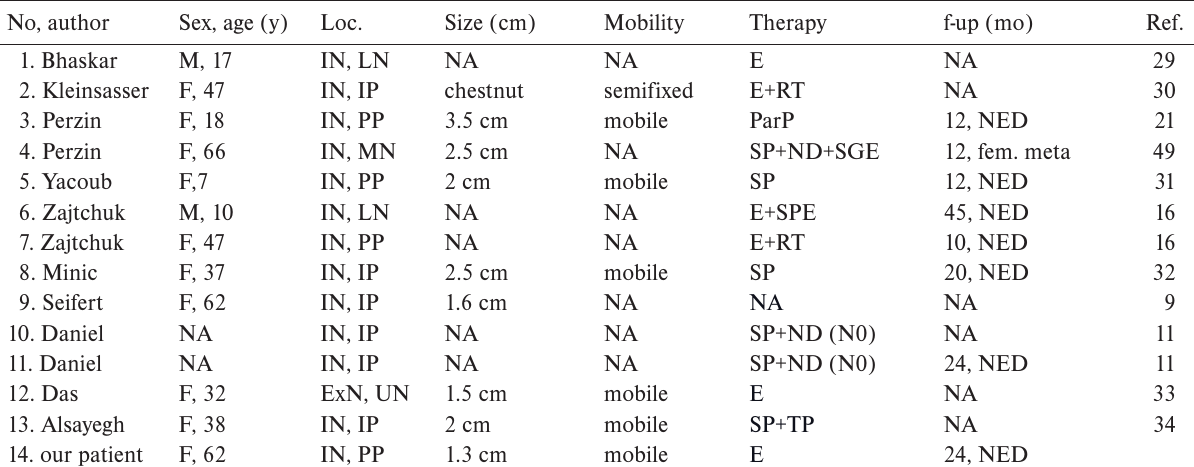
Table 1. Previously reported cases of heterotopic acinic cell